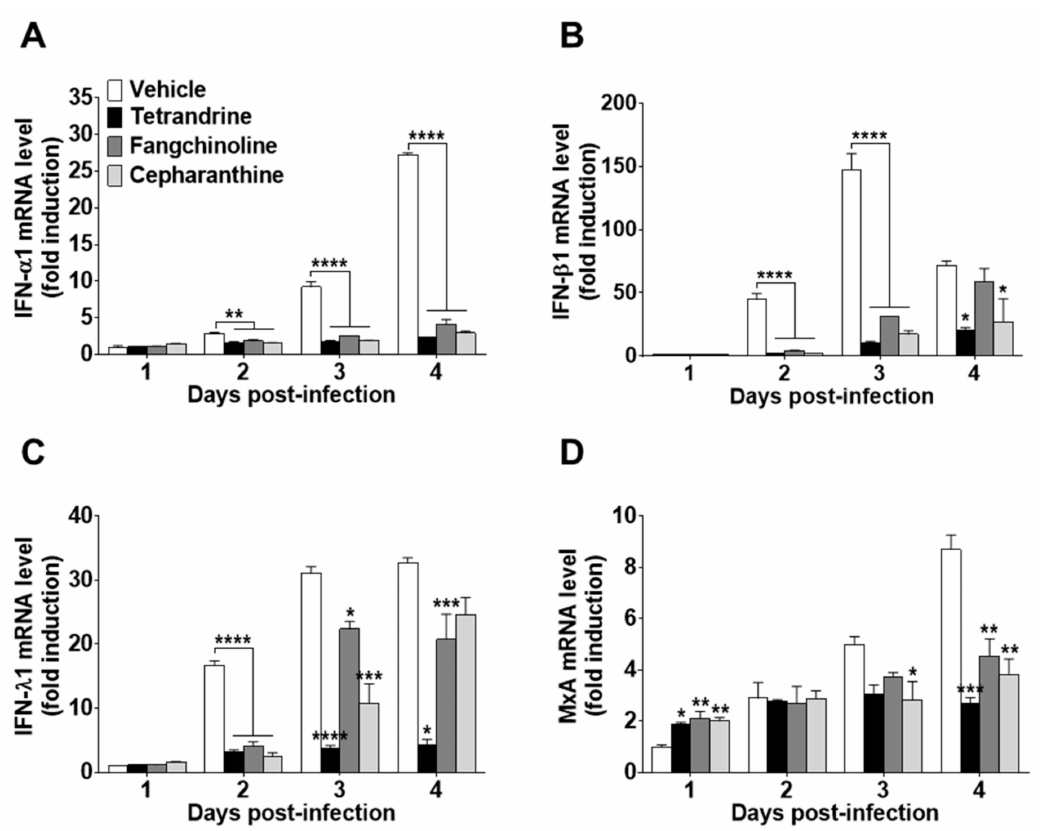
Figure 6. Reduced interferon (IFN)-related gene expression in TET-, FAN-, and CEP-treated HCoV-infected MRC-5 cells. The compounds (5 µ M) were added to HCoV-OC43-infected MRC-5 cells. Total RNA was purified from MRC-5 cells at days 1, 2, 3, and 4. ( A–D ) The mRNA levels of ( A ) IFN- α 1, ( B ) IFN- β 1, ( C ) IFN- λ 1, and ( D ) MxA genes were measured by qRT-PCR in vehicle (0.025% DMSO), TET-, FAN-, and CEP-treated cell lysates. β -Actin was used for data normalization. Data are presented as mean ± SEM of three independent experiments. * p < 0.05, ** p < 0.01, *** p < 0.001, and **** p < 0.0001 versus the vehicle group (one-way ANOVA plus Tukey’s multiple comparisons